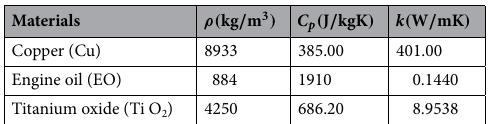
Table 2. Material properties of base fluid and nanoparticles at 293 K.